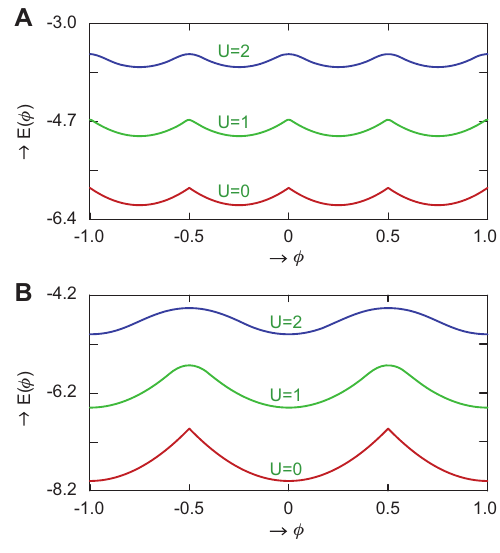
Figure 2 Ground state energy levels as a function of fl ux φ for some typical mesoscopic rings in half-fi lled case. The red, green, and blue curves correspond to U = 0, 1, and 2, respectively. (A) N = 5 and (B) N =